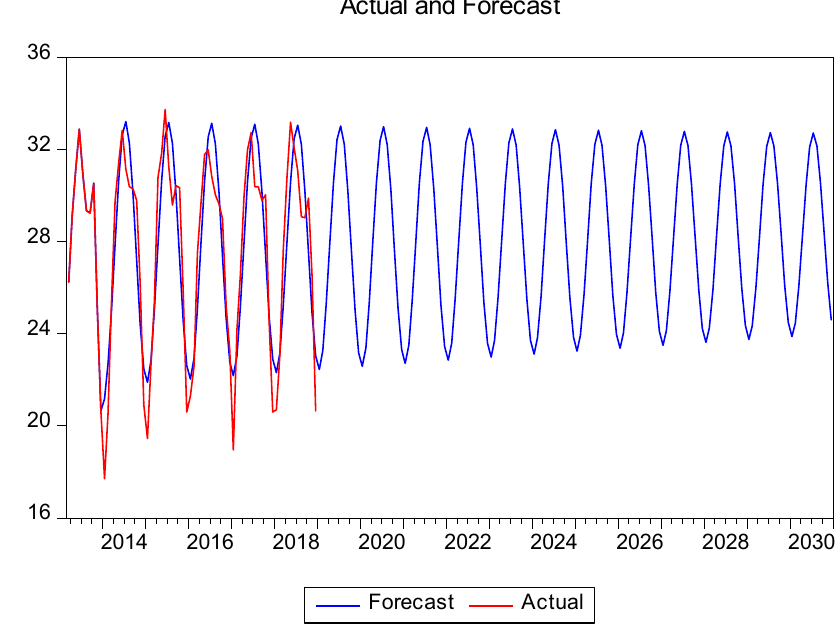
Figure 7. Depiction of extended forecast values through time series.